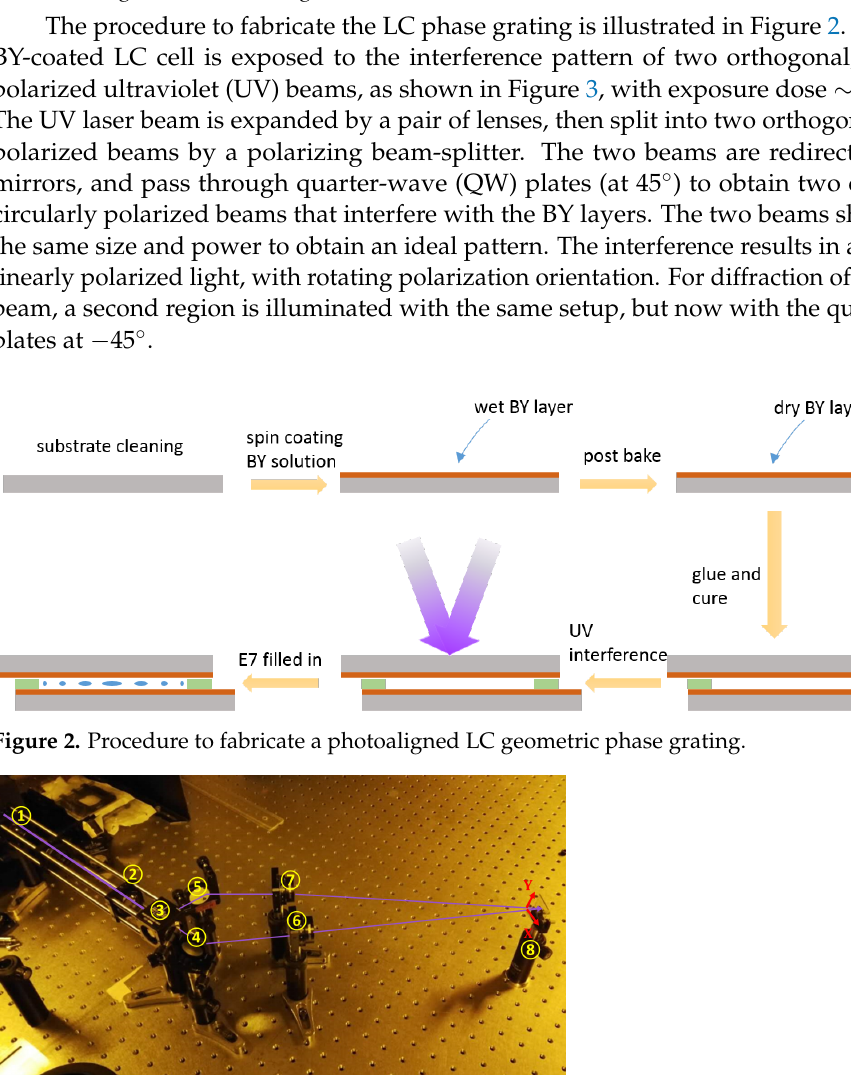
Figure 3. Set-up for writing the photoalignment pattern, with (1) (2) lenses to expand the UV beam; (3) polarizing beam splitter; (4) (5) mirrors; (6) (7) quarter-wave plates; (8) empty LC